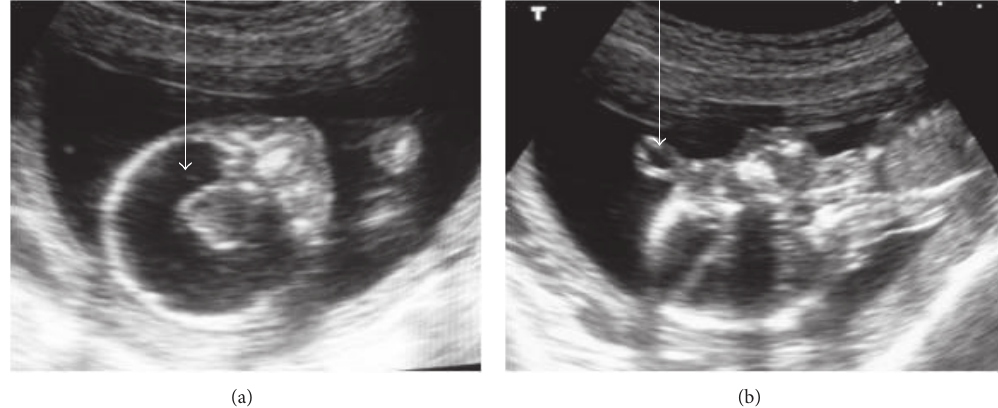
Figure 1: (a) Coronal ultrasound image showing the fused thalami in the centre and large monoventricle (thick white arrow). The amniotic fluid around the fetus is normal in quantity. (b) Sagittal ultrasound image showing the proboscis (thin white arrow) as a tubular cystic projection in the frontal region.